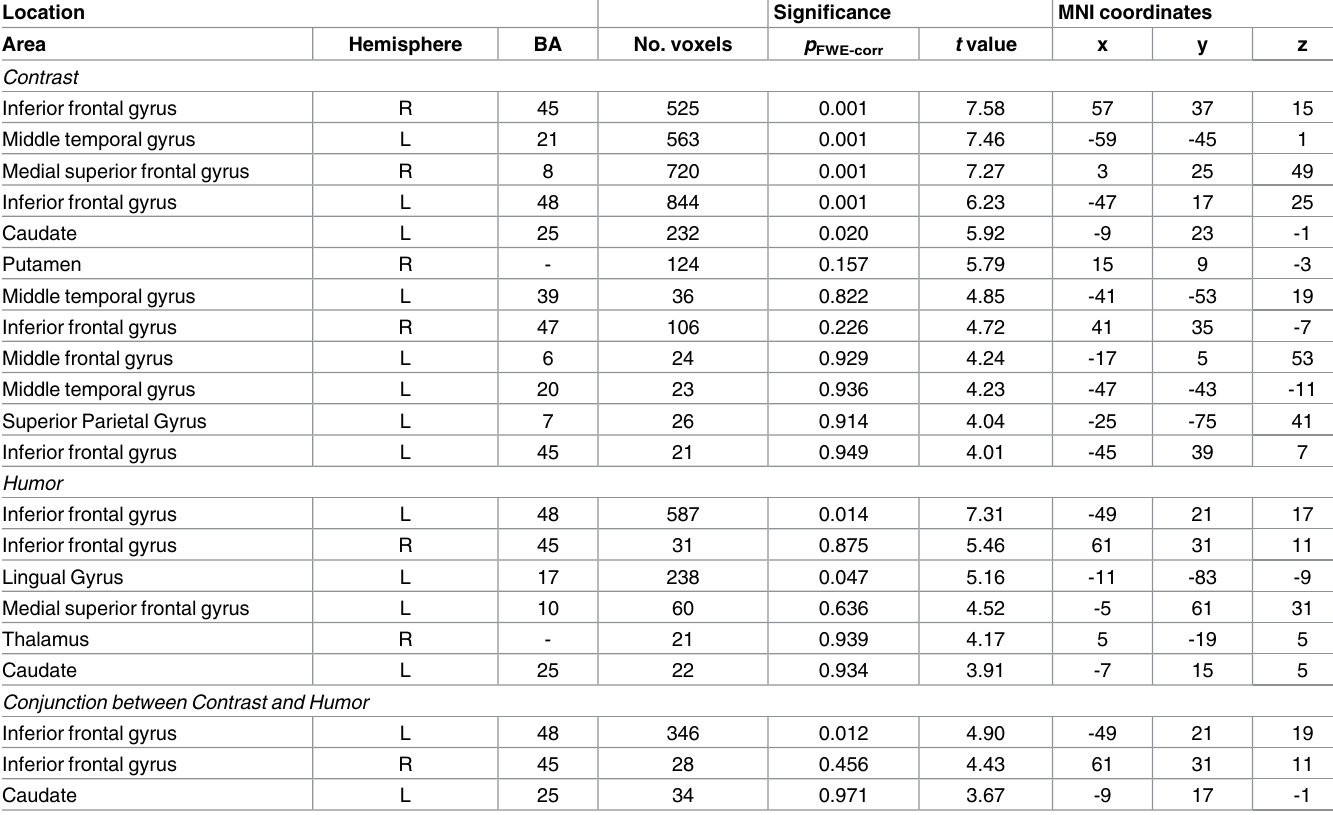
Table 4. Whole-Brain Activation for Contrast and